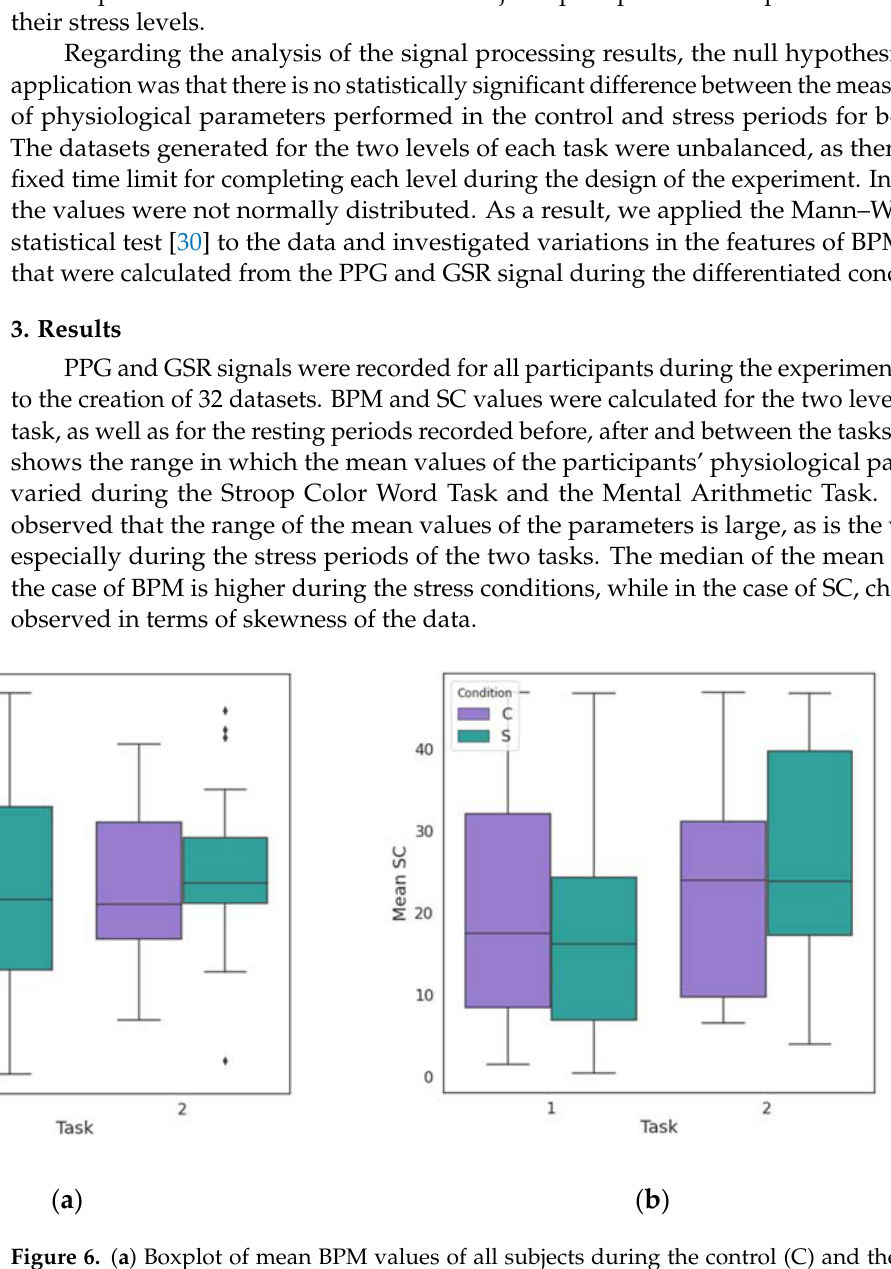
Figure 6. ( a ) Boxplot of mean BPM values of all subjects during the control (C) and the stress (S) conditions of the Stroop Color Word Task (Task 1) and the Mental Arithmetic Task (Task 2). ( b ) Boxplot of mean SC values of all subjects during the control (C) and the stress (S) conditions of the Stroop Color Word Task (Task 1) and the Mental Arithmetic Task (Task 2). The ends of the whisker are set to 1.5 times the interquartile range above the third quartile (Q3) and 1.5 times the interquartile range below the first quartile (Q1). The outliers are shown for each condition by the diamond